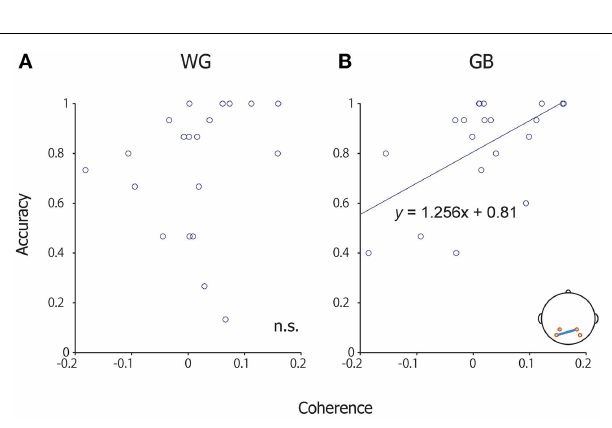
FIGURE 5 | Scatter plot of coherence and accuracy . (A) Scatter plot of coherence and accuracy under theWG condition. (B) Scatter plot of coherence and accuracy under the GB condition.The horizontal axis shows coherence between P4 and Po7, and the vertical axis shows accuracy during the P300-BCI task. A significant correlation was observed under the GB